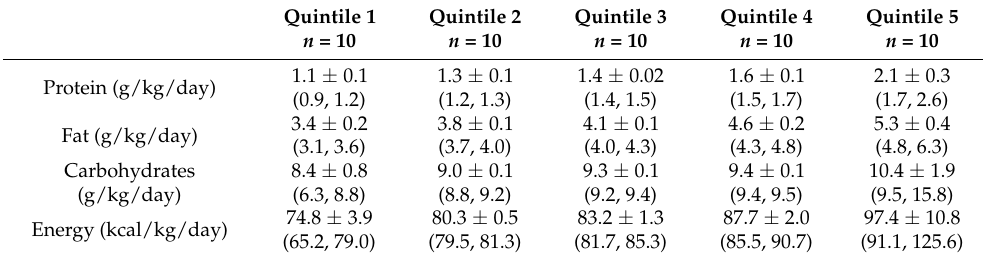
Table 2. Macronutrient intake from human milk in each quintile.